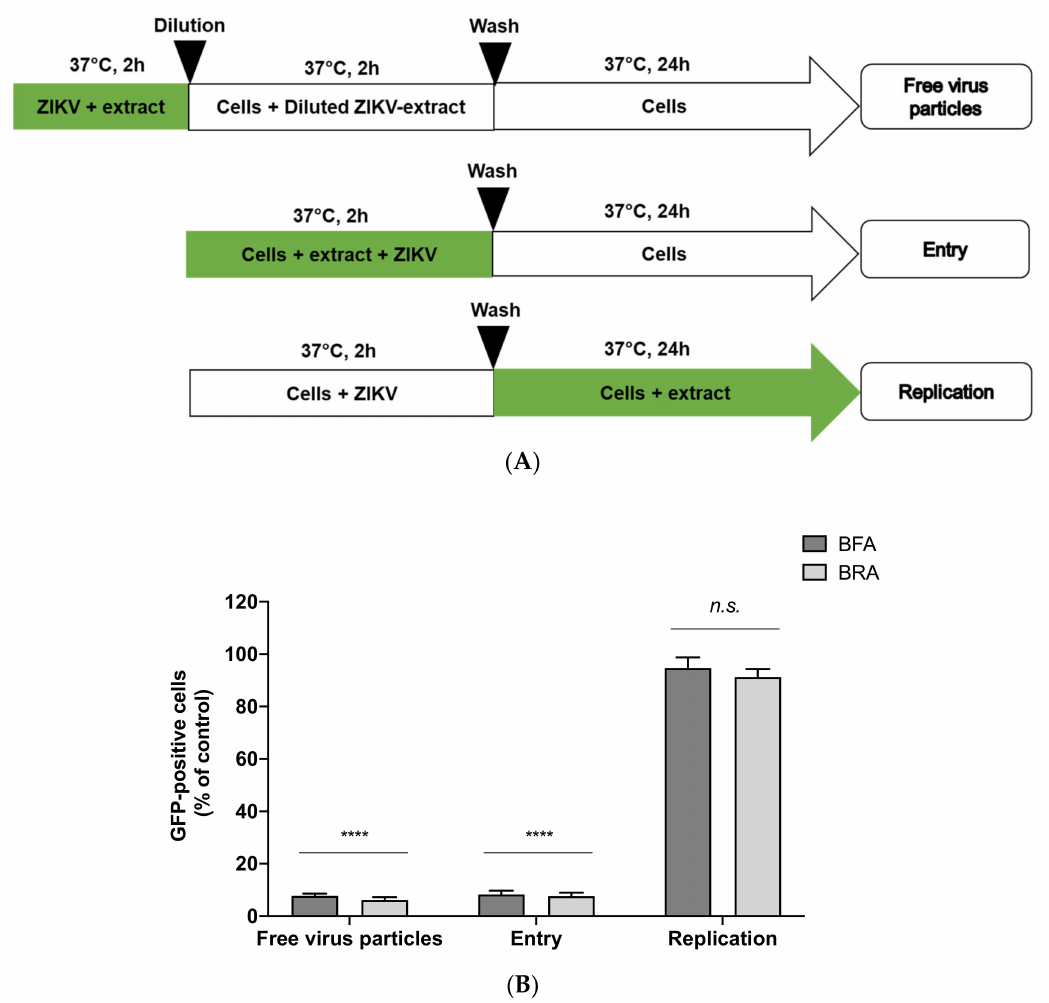
Figure 4. B. gymnorhiza extracts inhibit ZIKV entry in human cells. ( A ) Schematic diagram representing the time-of-drug- addition assay. The green segments in the arrows show the presence of extract during infection. ( B ) Flow cytometric analysis of GFP expression in A549 cells infected with ZIKV GFP at MOI of 2 PFU/cell under the experimental conditions as illustrated in ( A ). Results are given as means ± SD of three independent experiments and expressed as relative values in contrast to the control. **** p < 0.0001 indicates significant differences in the extracts; n.s. = not